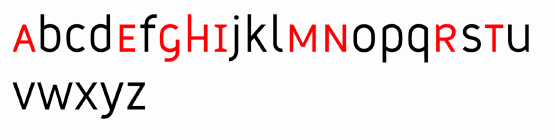
Figure 11. The typeface ‘Grid Sans Unicase.’